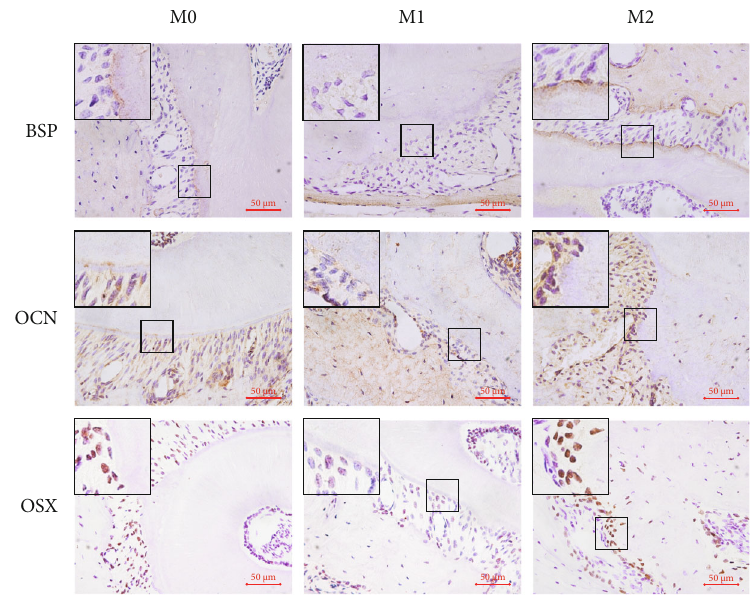
Figure 8: Exosomes from macrophages with di ff erent polarization phenotypes in fl uenced cementoblast mineralization in vivo . Representative immunohistochemical images of BSP, OCN, and OSX in the roots of maxillary molars in the groups of mice injected with exosomes from M0, M1, or M2. Scale bars: 50 μ